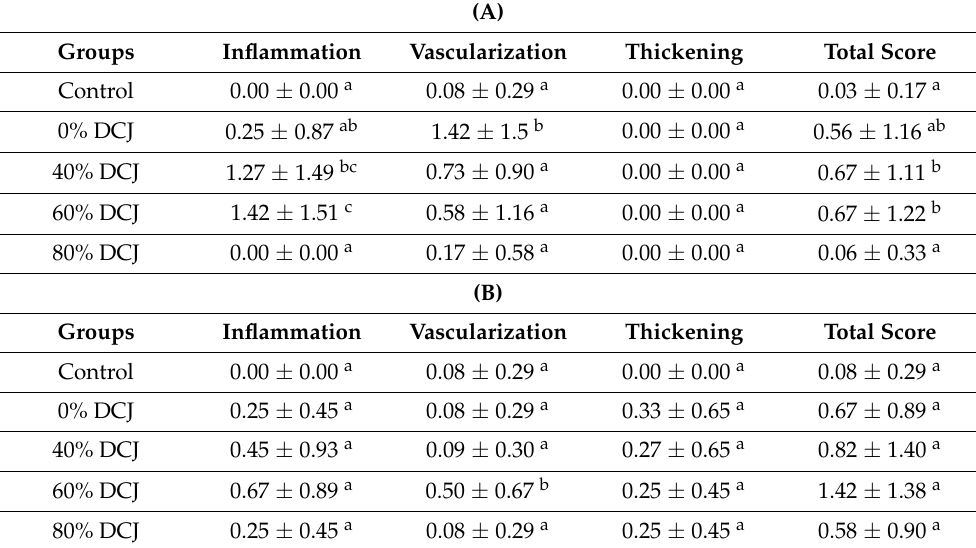
Table 2. Effect of the deacidification of CJ on the inflammatory estate of ( A ) the ileum and ( B ) the colon. Results are presented as means ± SD for each group at each column ( n = 12). The last column indicates the final score for each group and a different letter in this column indicates a statistically significant difference between the groups at a probability level of p < 0.05.